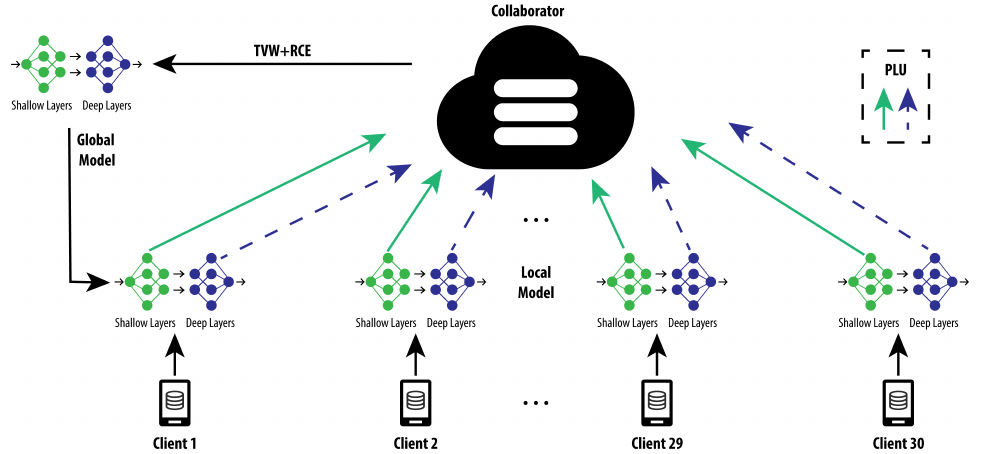
Figure 4. The deployment architecture of